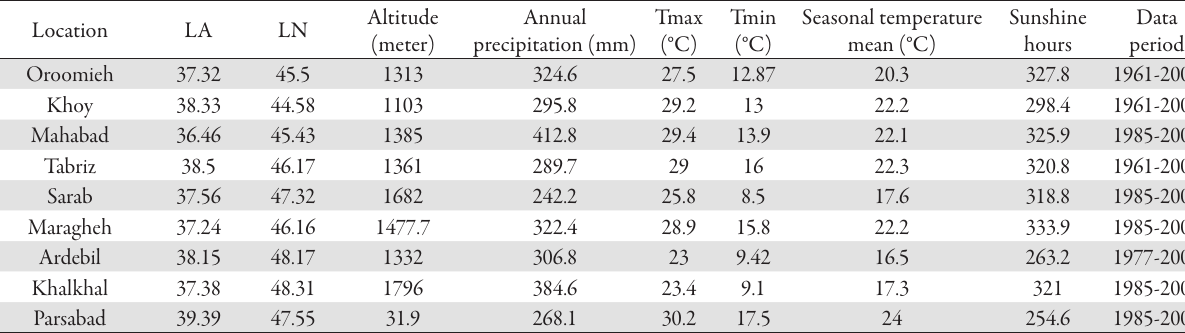
Tab. 3. Climatic features of various study locations in Azerbaijan